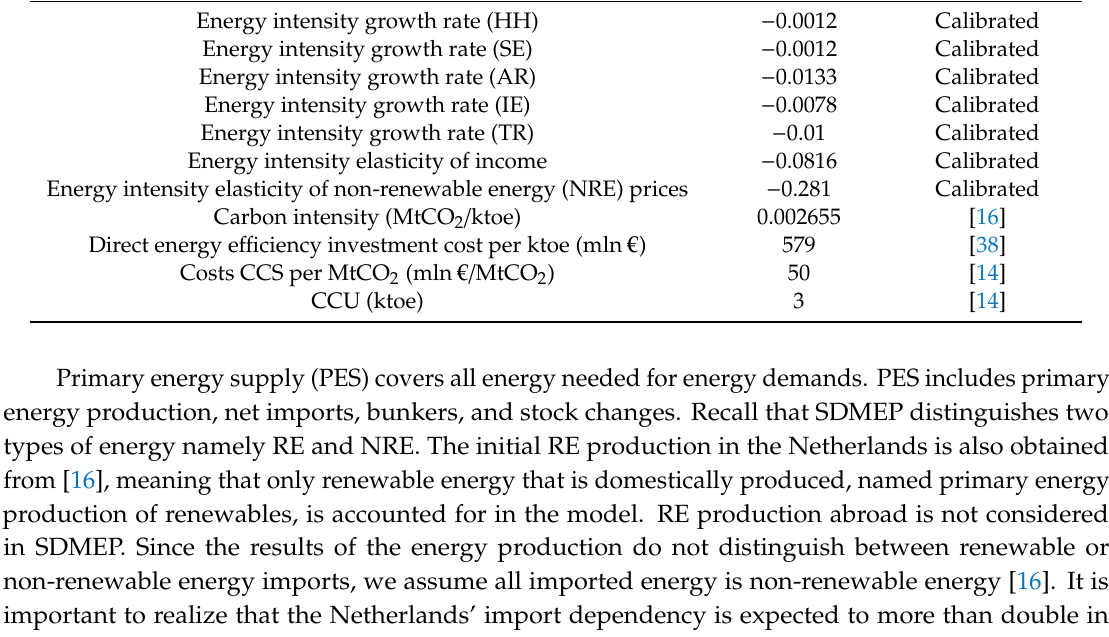
Table 3. Parameter values of the energy